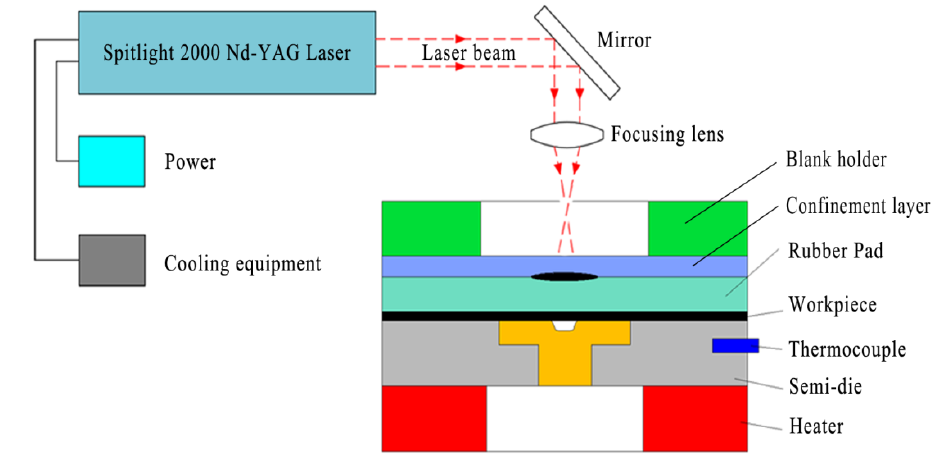
Figure 1. The schematic of μLDFF process.